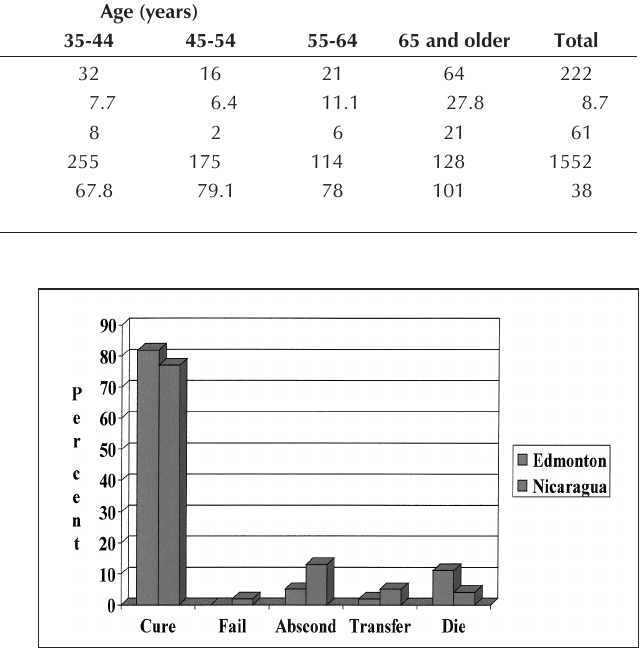
Figure 1) Treatment outcomes of tuberculosis treatment in Alberta and